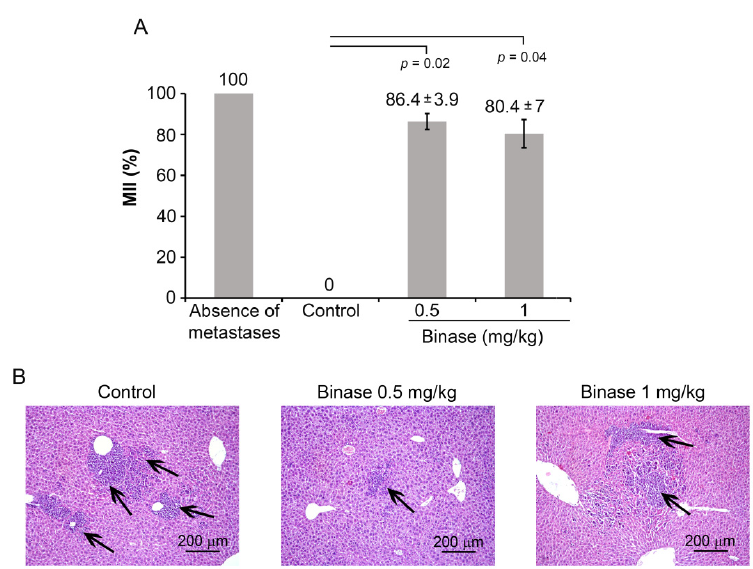
Figure 3. The effect of binase on the metastasis development in RLS 40 -bearing mice. ( A ) Metastasis inhibition index (MII) in the control (saline bu ff er) and experimental groups (binase 0.5 and 1 mg / inhibition index (MII) in the control (saline buffer) and experimental groups (binase 0.5 and 1 mg/kg). MII = ((mean metastasis area control − mean metastasis area experiment )/mean metastasis area control ) × 100%.